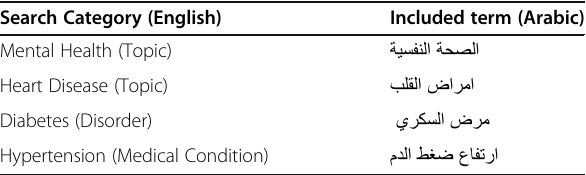
Table 1 Global Public Health Days search category